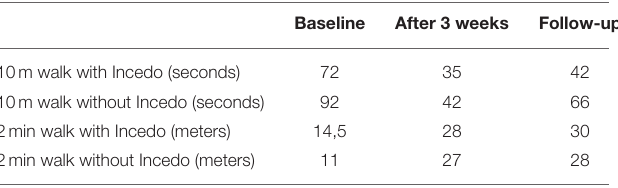
TABLE 2 | Kinematic gait analysis before and after a 3-week training period. TABLE 1 | The 10m walking test and 2min walking test before and after a 3-week training period and at follow-up. Baseline After 3 weeks Follow-up 10m walk with Incedo (seconds) 72